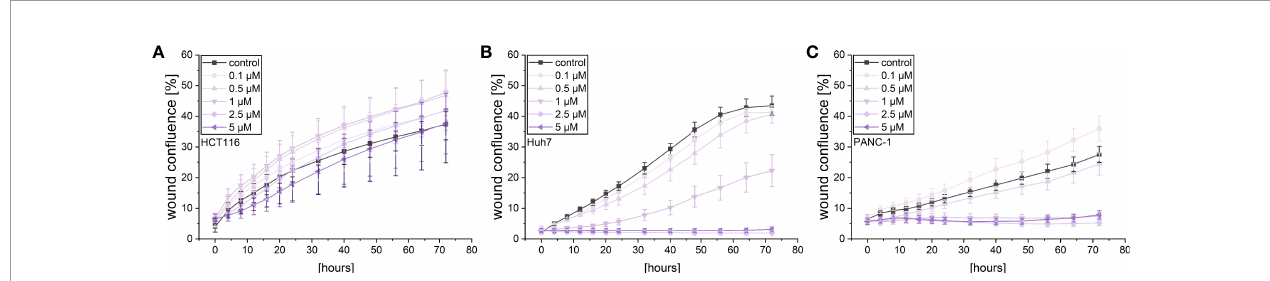
FIGURE 3 | Live-cell microscopy-based analysis of the effect of violacein on cell migration. After wounding, wound con fl uence of violacein or DMSO solvent control- treated (A) HCT116, (B) Huh7, and (C) PANC-1 cells was monitored in an IncuCyte ® S3 system over 72 h.